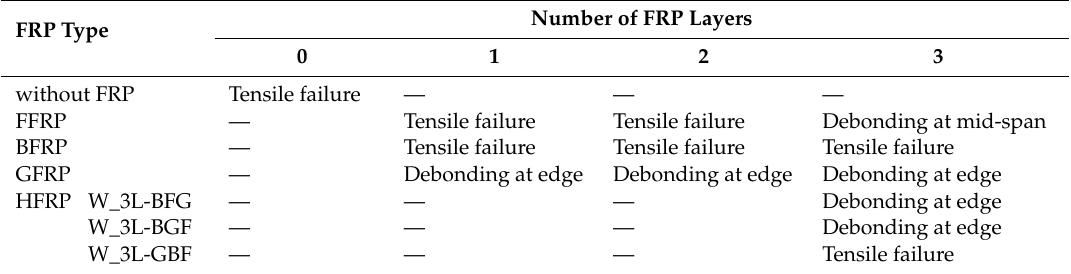
Table 4. General failure modes for control and FRP strengthened wood